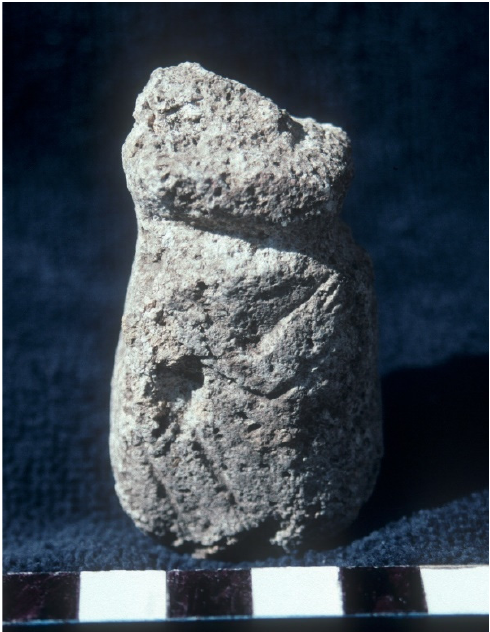
Figure 3. Small-sized ancestor figure excavated at Chinchawas. Note the flat mask-like face and seated position; height 6.4 cm, width 3.6 cm. Photograph by author.